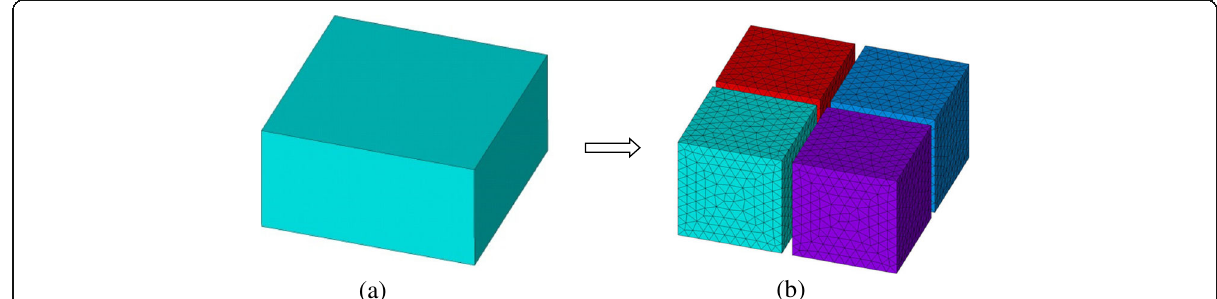
Fig. 1 A domain division scheme with non-overlapping subdomains in the FETI-DP method. a Original domain. b Divided subdomains and discretized